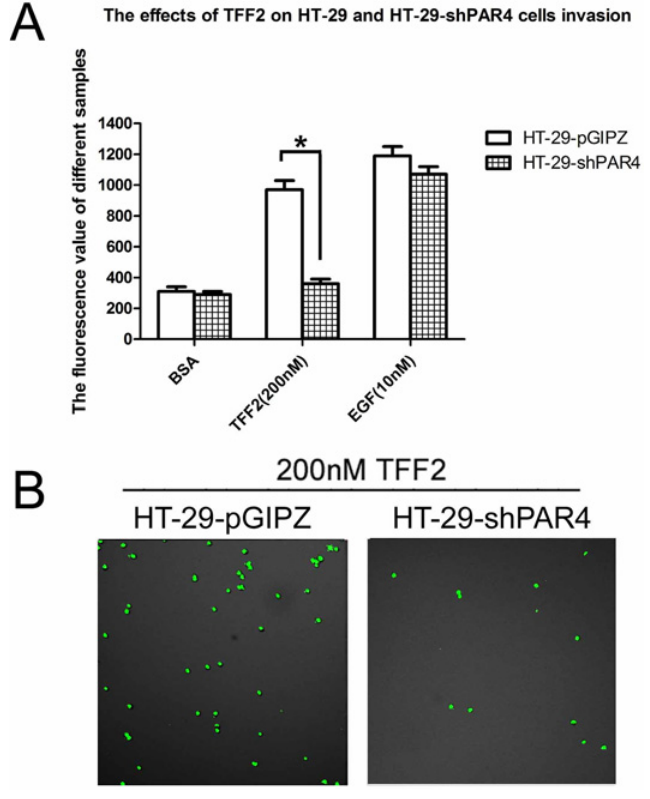
Fig 5. Effect of recombinant TFF2 on cell invasion of PAR4-knockdowned HT-29 cells. (A) Cell invasion stimulated by TFF2 was tested using an InnoCyte cell invasion assay. Invasion activity of HT-29-pGIPZ and HT-29-shPAR4 cells were treated with 200 nM TFF2 to assess the invasion activity, BSA and 10nM EGF were used as controls. There was significant difference of 200nM TFF2 on HT-29-pGIPZ and HT-29-shPAR4 cells invasion. Data were presented as means ± SD of three independent experiments, * p < 0.05; (B) Invasion cells of HT-29-pGIPZ and HT-29-shPAR4 stimulated by 200nM TFF2 were investigated by Confnocal laser fluorescence